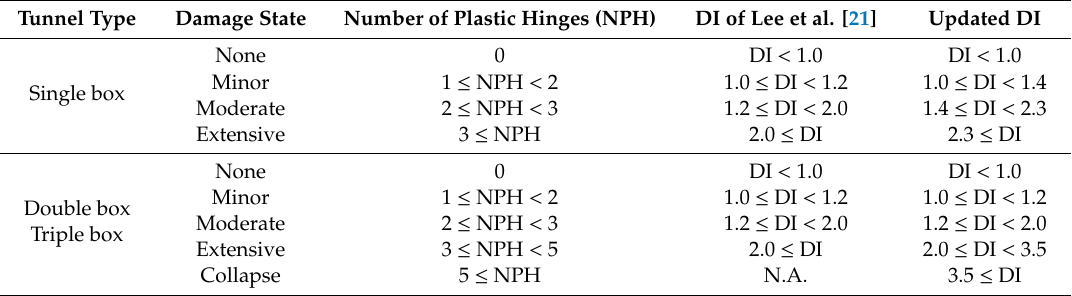
Table 1. Updated definitions of damage states and corresponding DIs. Damage state definitions and DIs of Lee et al. [21] are listed for comparison